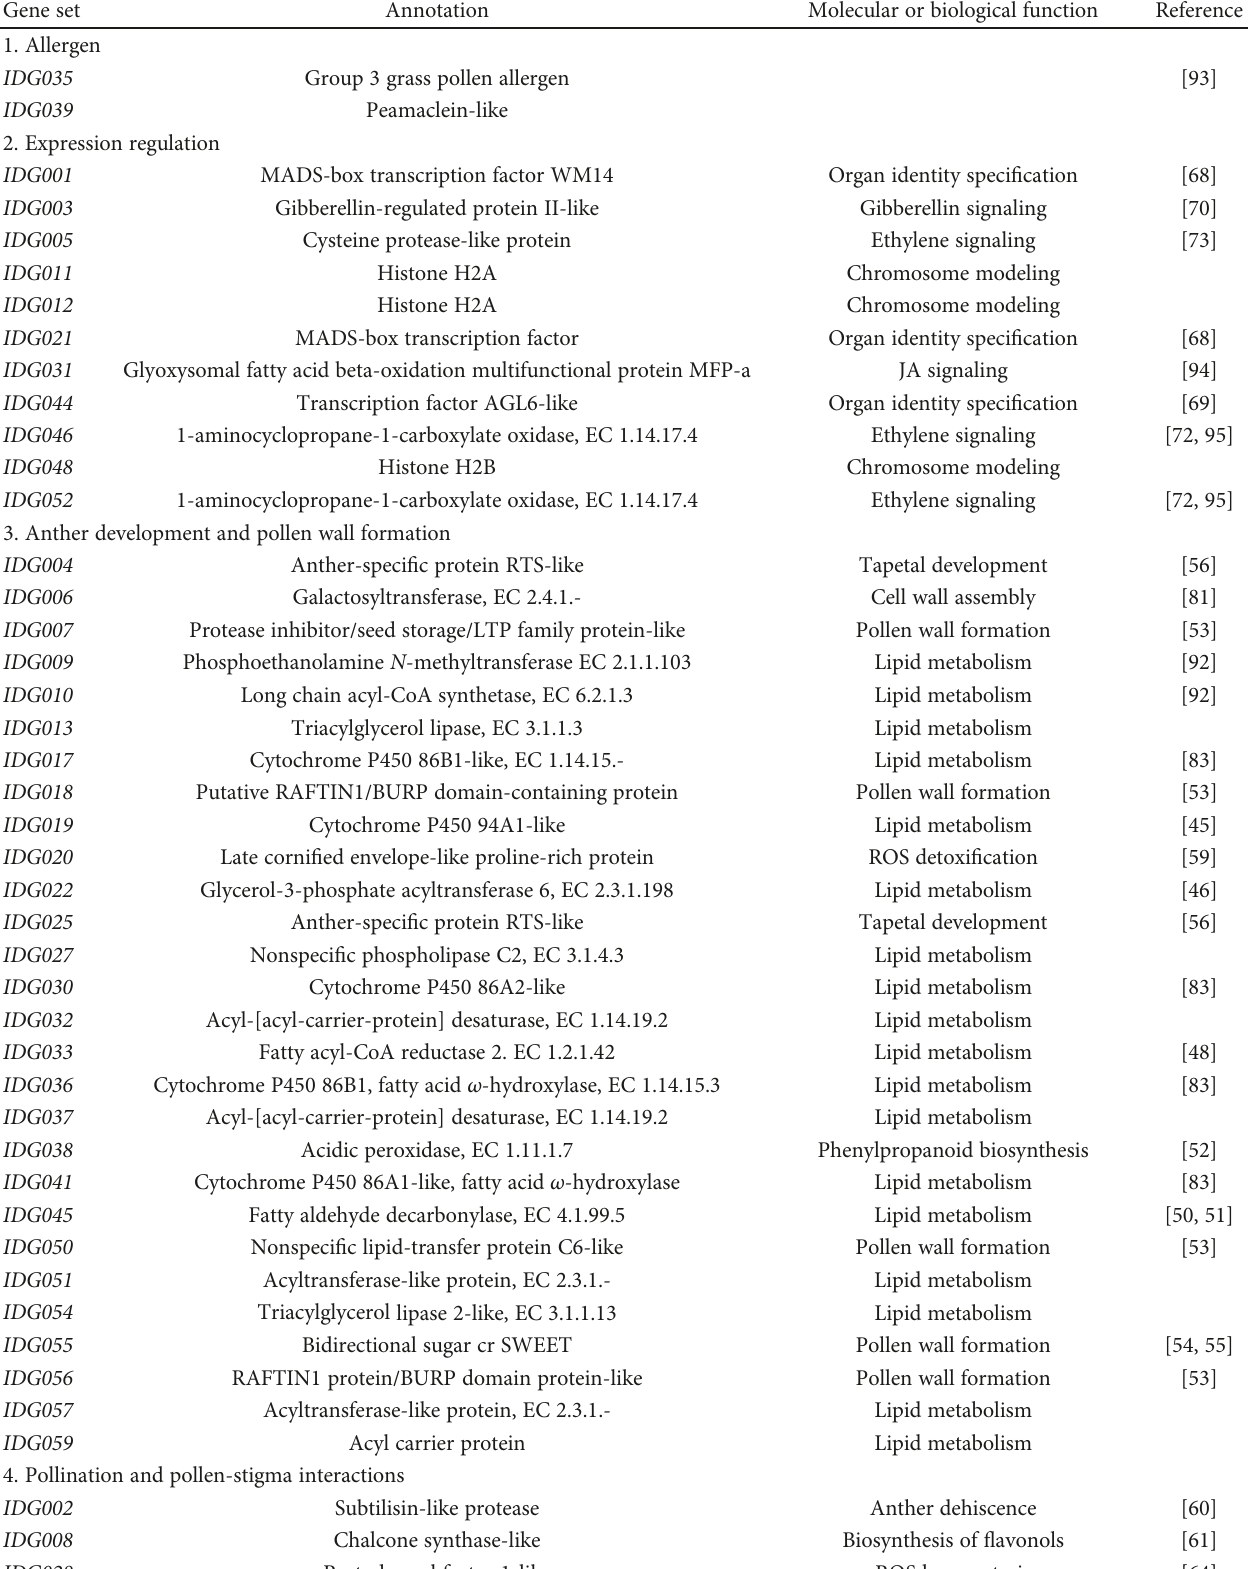
Table 2: Functional classi fi cations of the annotated gene